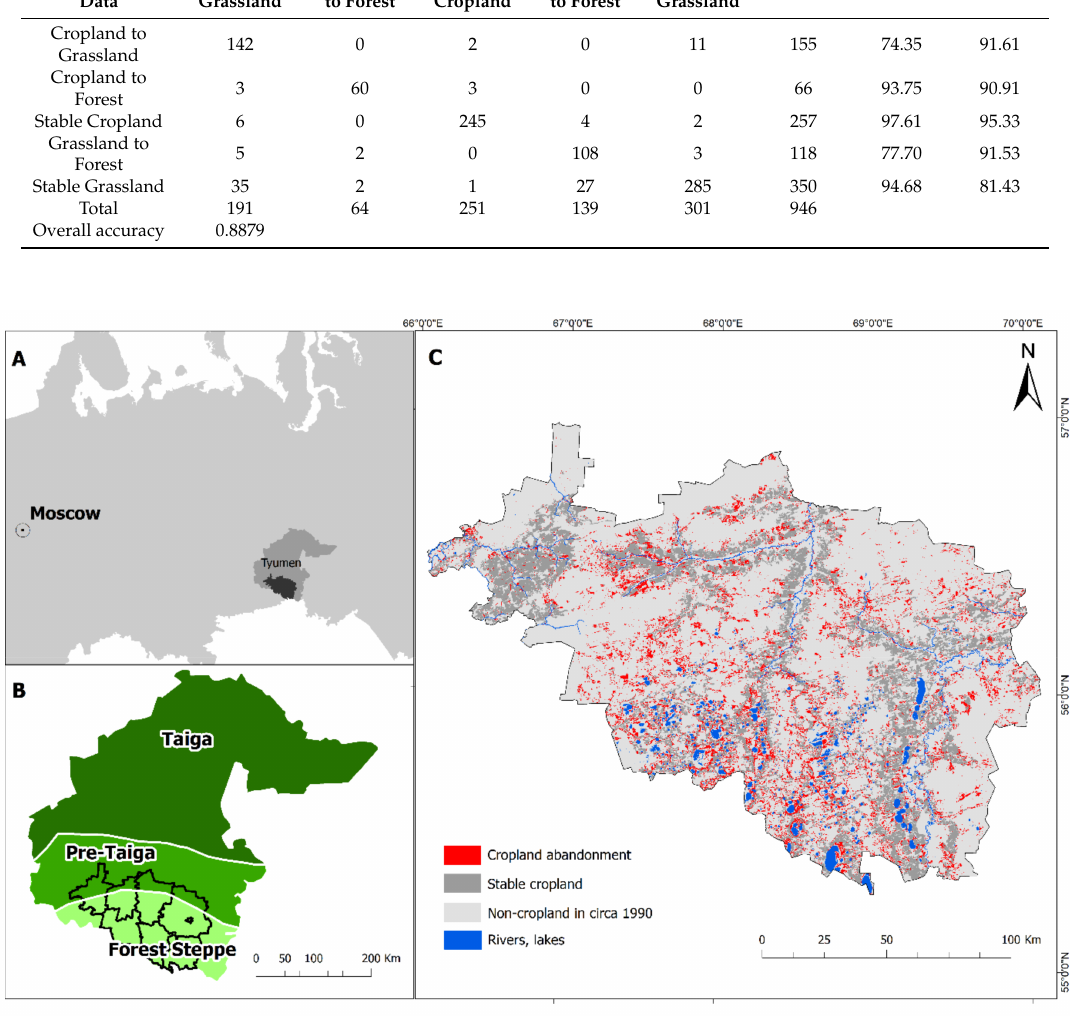
Figure 1. Location of Tyumen province and the study area (darker grey area, panel A ), ecozones of Tyumen region ( B ), and change map from the remote sensing classifications for ca. 1990 and ca. 2015, highlighting areas of cropland abandonment and stable cropland ( C